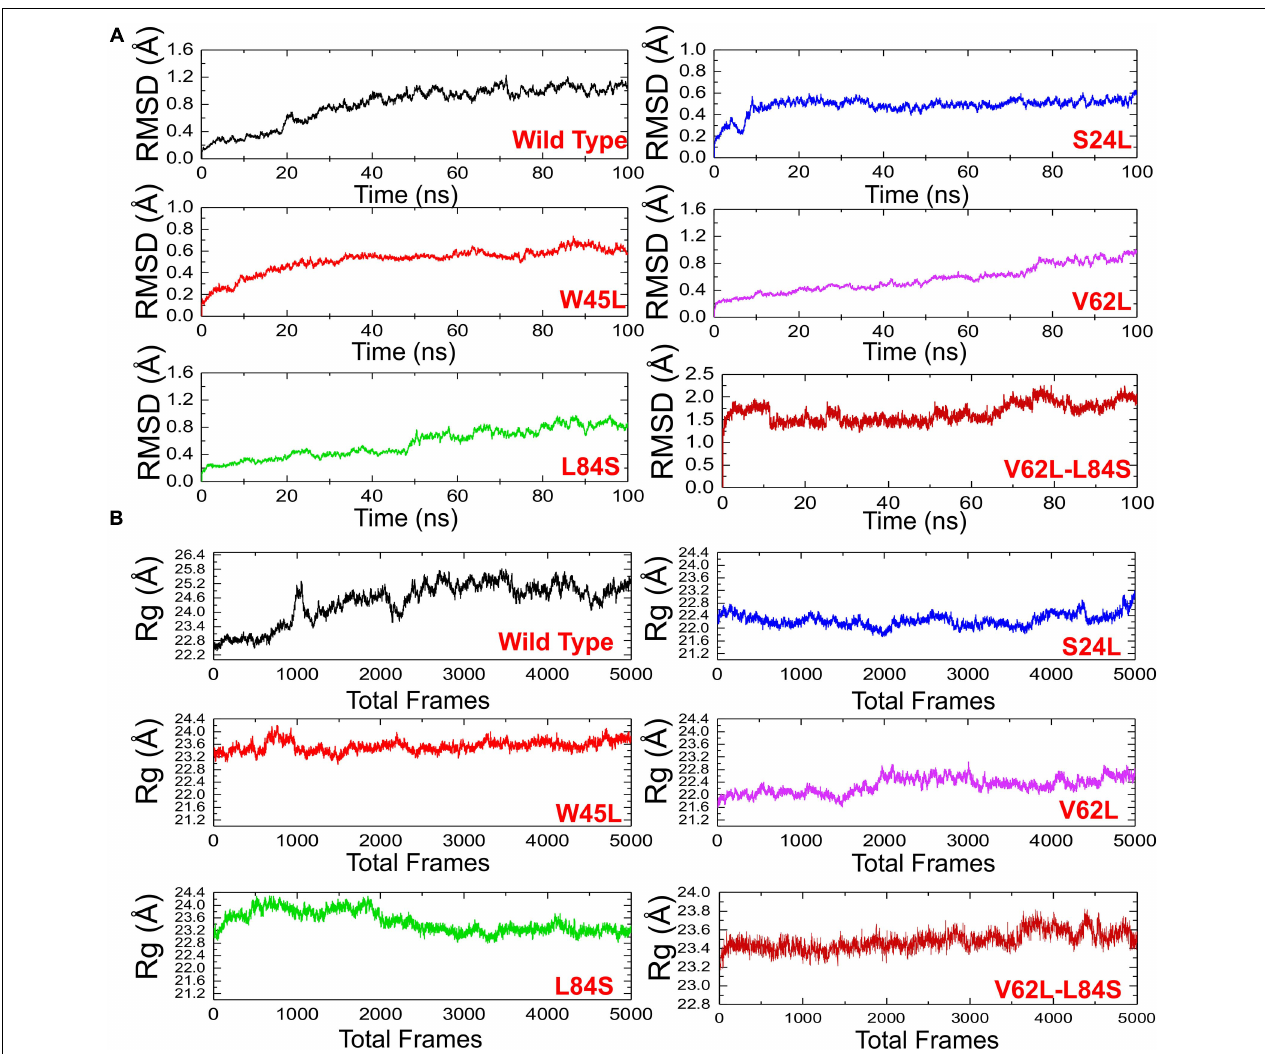
FIGURE 4 | The RMSDs and Rgs of all complexes. (A) The RMSD of ORF8 WT was shown in black, while other mutants in different colors. RMSDs, root mean square deviations. (B) Rg (s) of ORF8 WT was shown in black, while the other mutants were given in different colors. Rg, Radius of gyration.